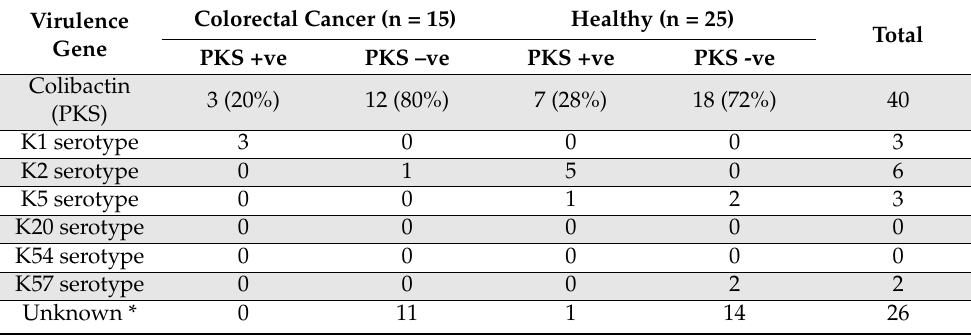
Table 2. K. pneumoniae presence of PKS colibactin gene and capsular